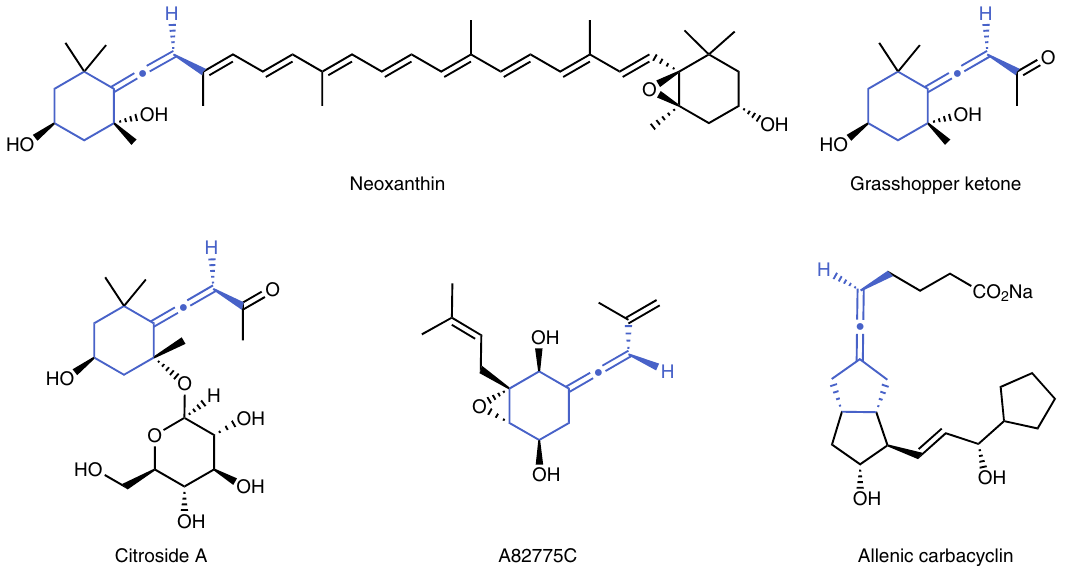
Fig. 1 Bioactive allenes. Representative examples of chiral exocyclic allenes in natural products and